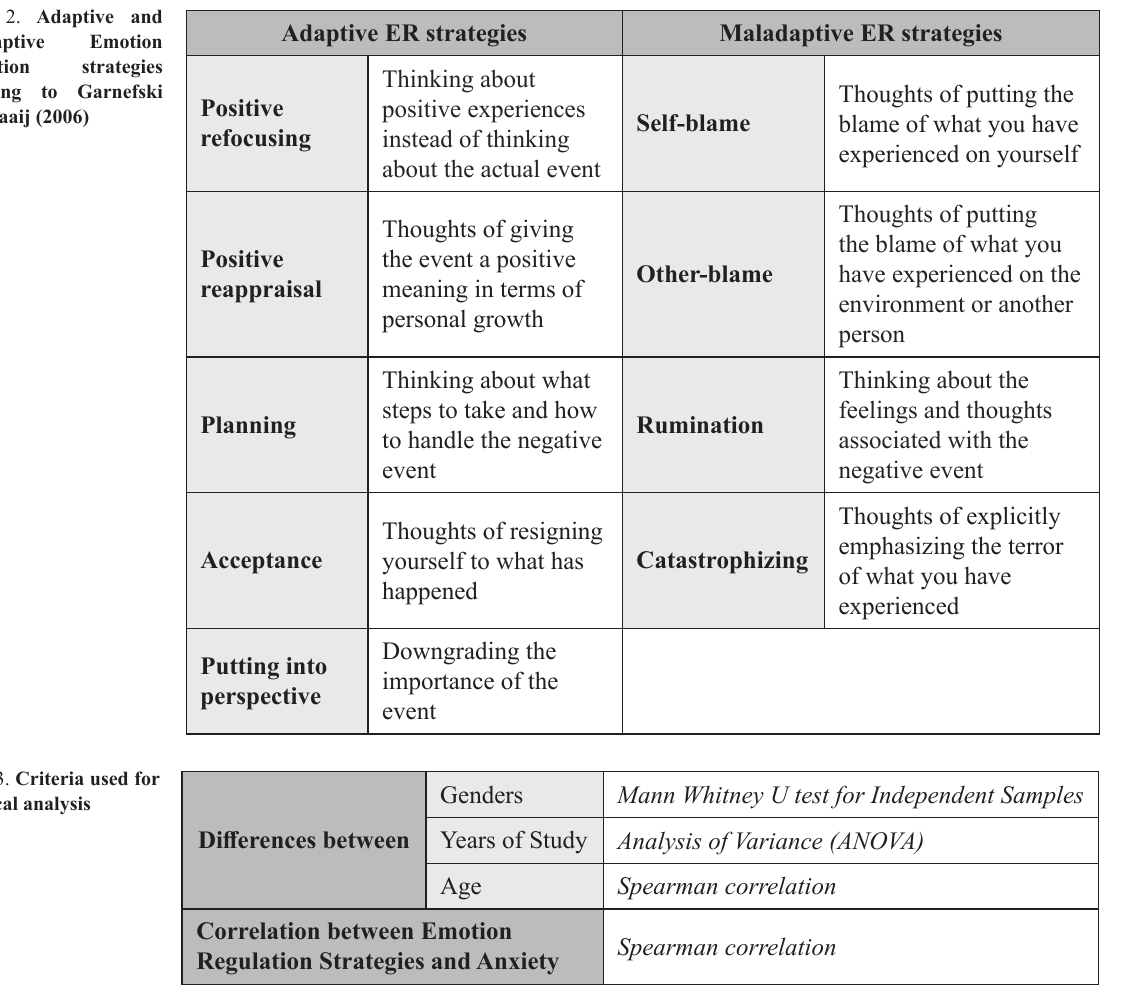
Figure 3. Criteria used for statistical